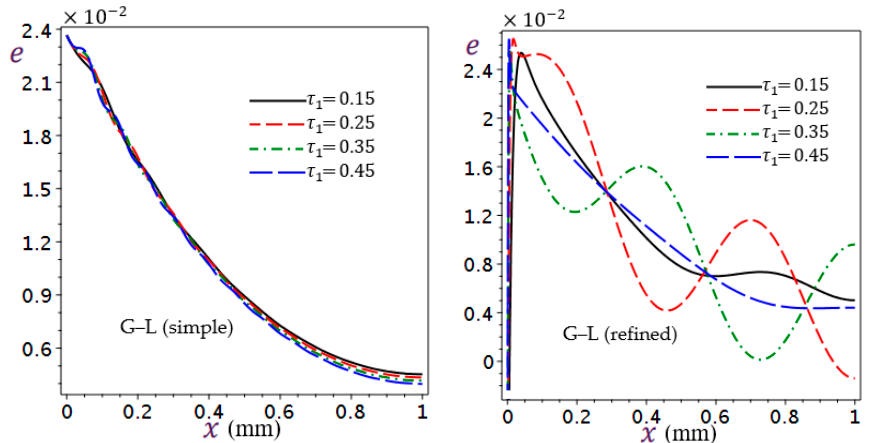
Figure 12. Effect of first relaxation time τ 1 of G–L theory on dilatation e .